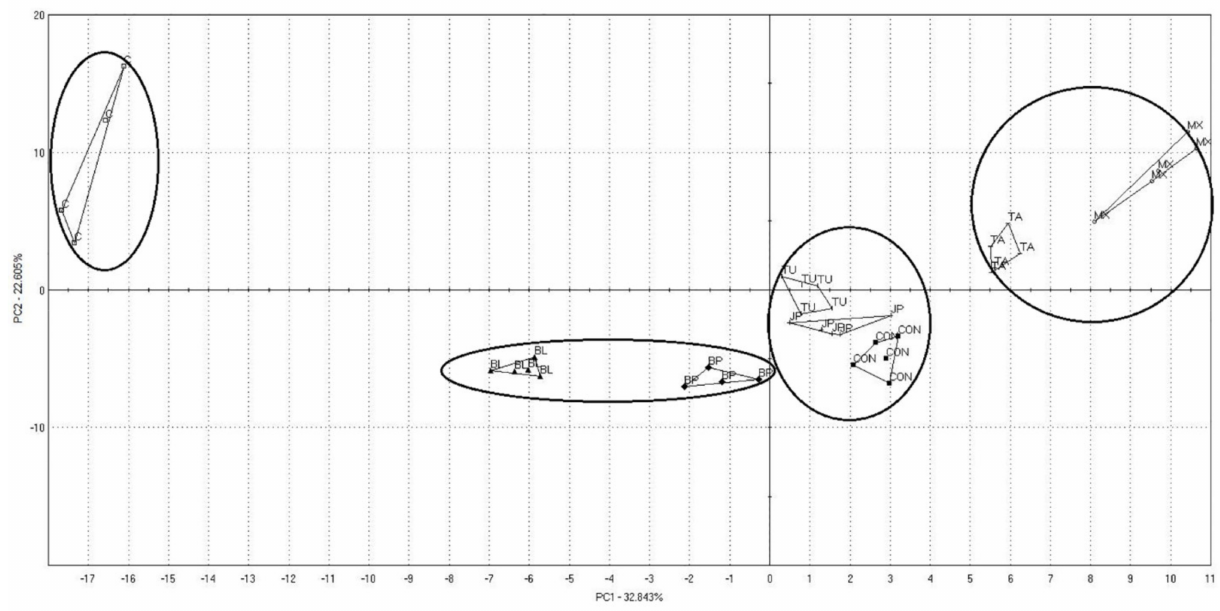
Figure 3. Volatile compounds identified in grilled pork meat